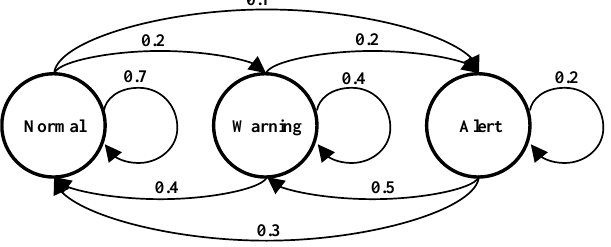
Figure 4. Markov model state transition diagram in which there are three possible states, and state transition occurs according to the transition weights, as indicated.